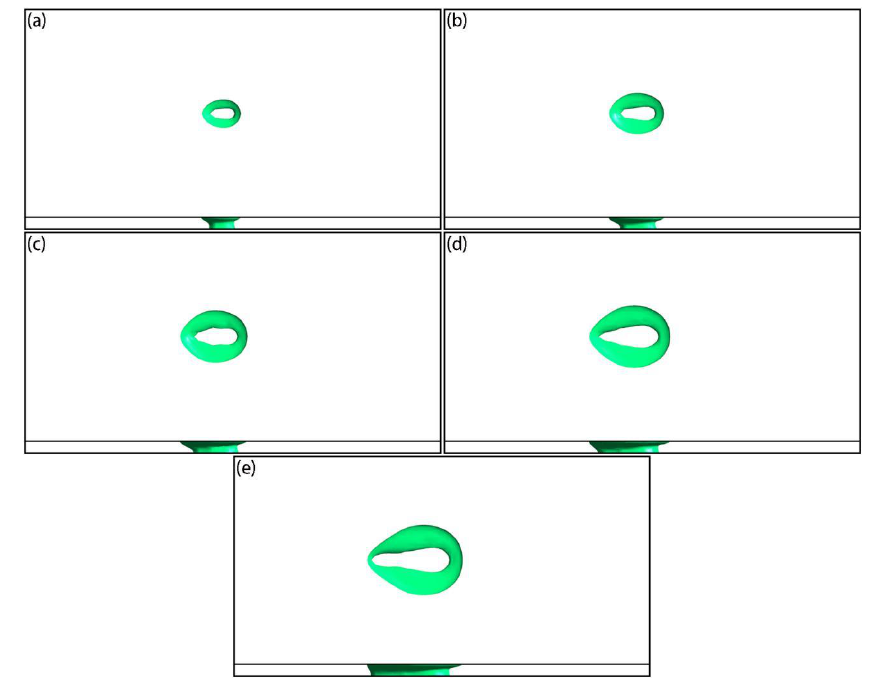
Figure 12. Simulation results of top- and side-view molten pool shapes under different laser powers when the laser acted on the center of the powder layer: ( a ) 150 W; ( b ) 200 W; ( c ) 250 W; ( d ) 300 W; ( e ) 350 W.